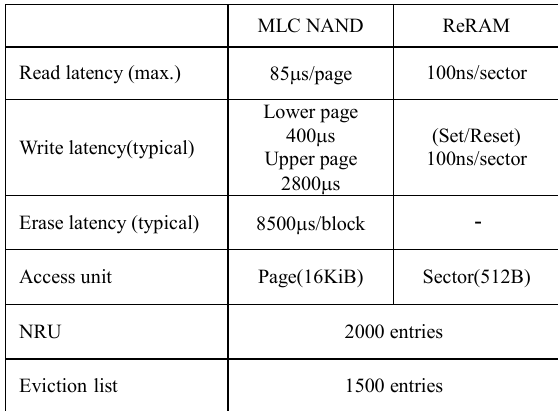
Table 1. MLC NAND/ReRAM Specification and Used Table